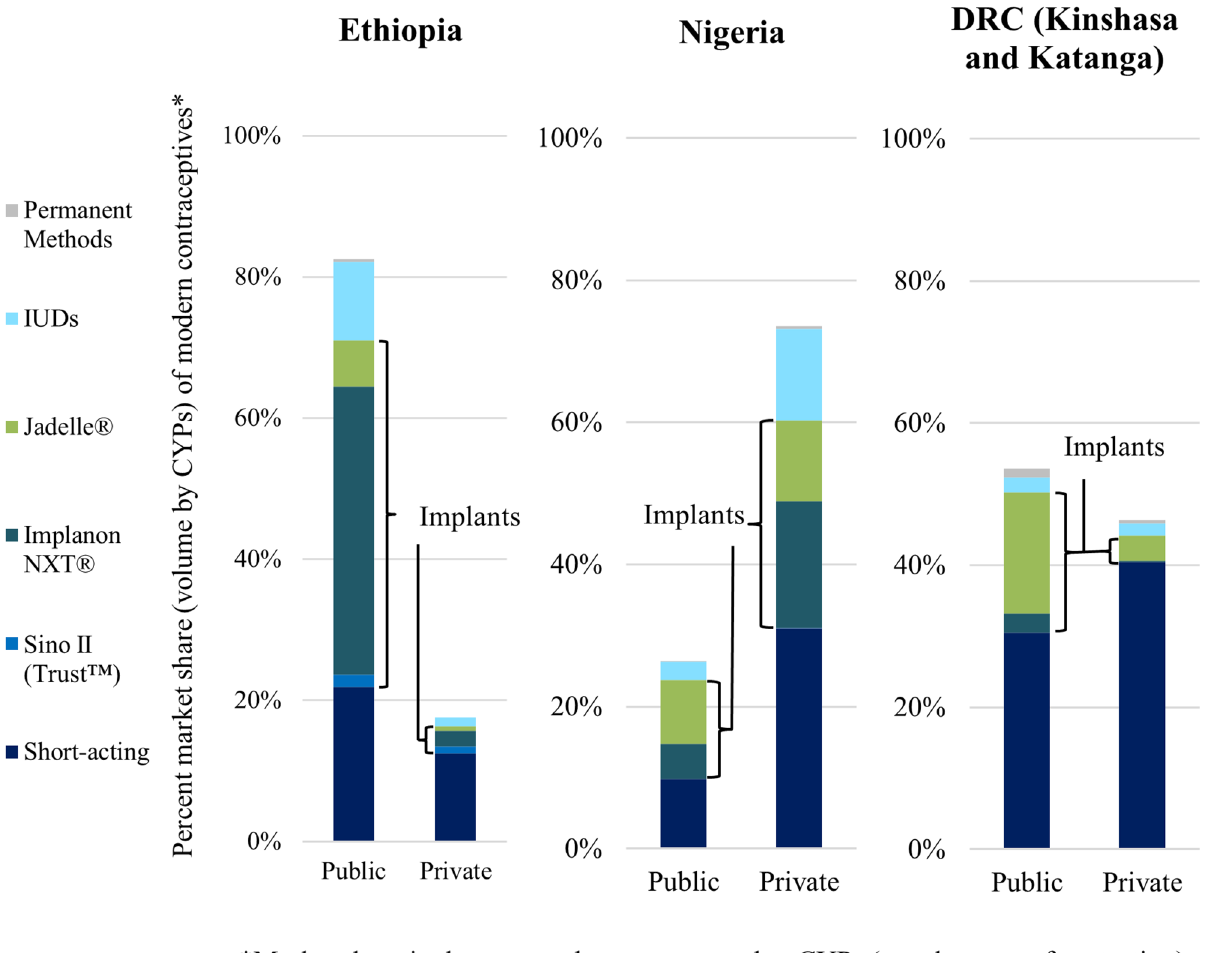
Fig 3. Market share of modern contraceptive methods across outlet